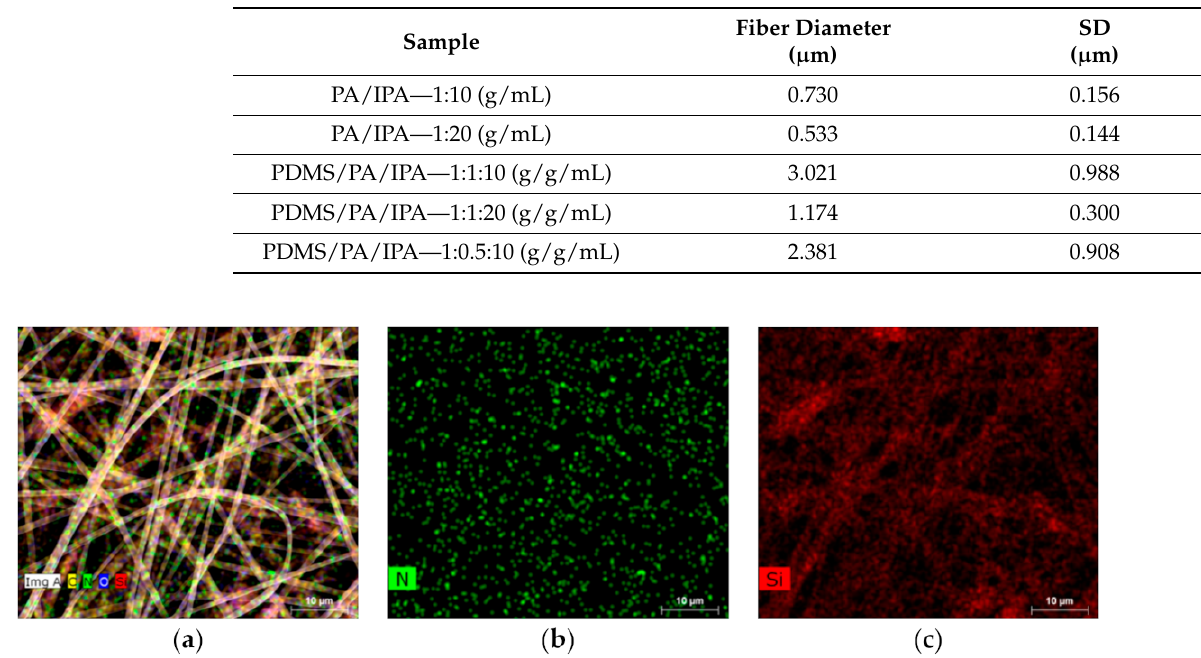
Figure 2. SEM images of the PDMS/PA fiber mats produced on Al: ( a ) PA/IPA—1:10 (g/mL), ( b ) PA/IPA—1:20 (g/mL), ( c ) PDMS/PA/IPA—1:1:10 (g/g/mL), ( d ) PDMS/PA/IPA—1:1:20 (g/g/mL), ( e ) PDMS/PA/IPA—1:0.5:20 (g/g/mL). Table 2. Thickness of electrospun fibers.